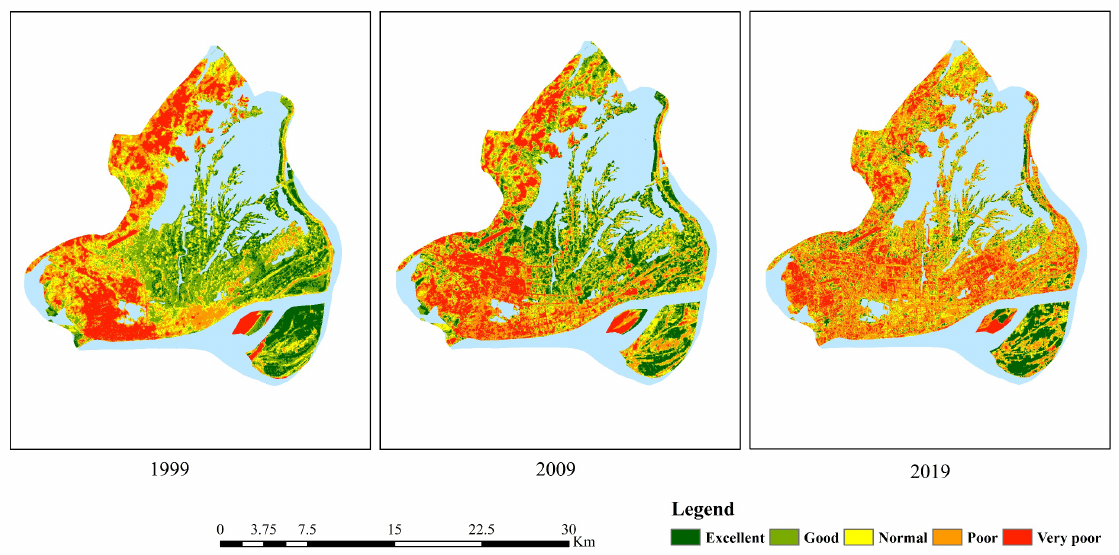
Figure 4. Spatial distribution of five eco-environmental quality classes for urban area of Anqing in 1999, 2009, and